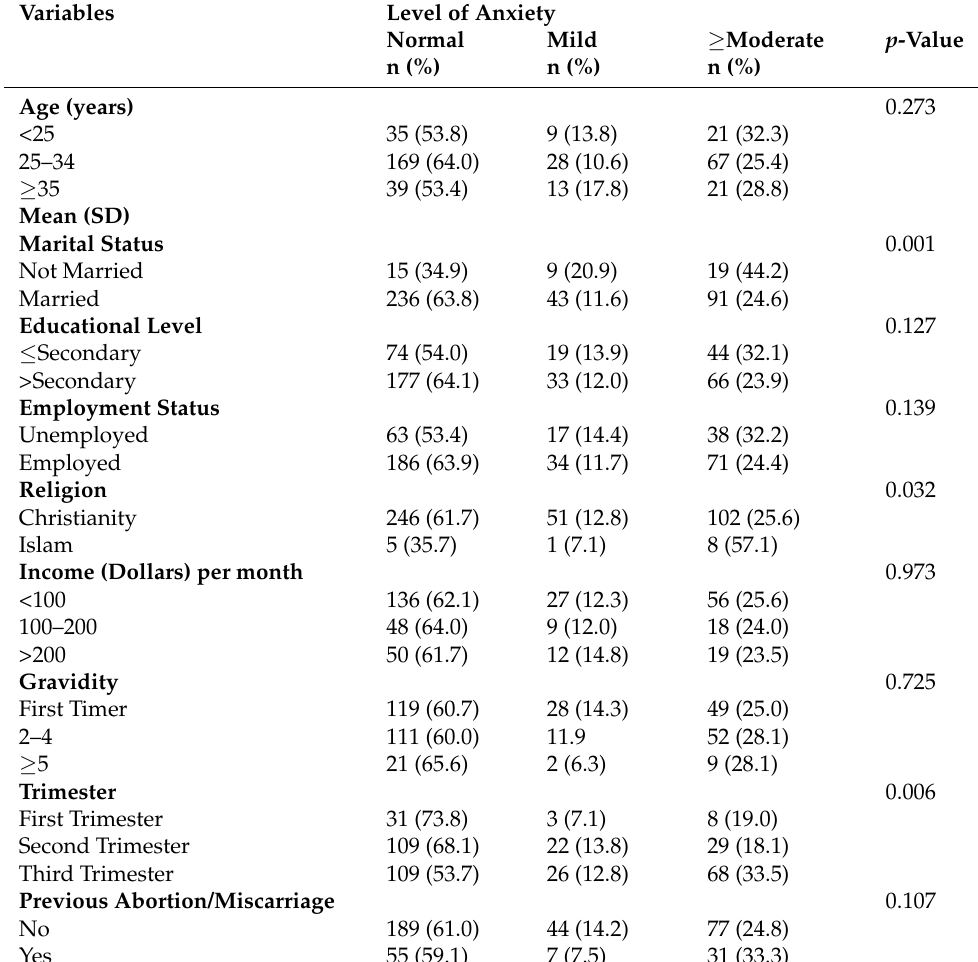
Table 4. Associations between the respondents’ characteristics and anxiety.